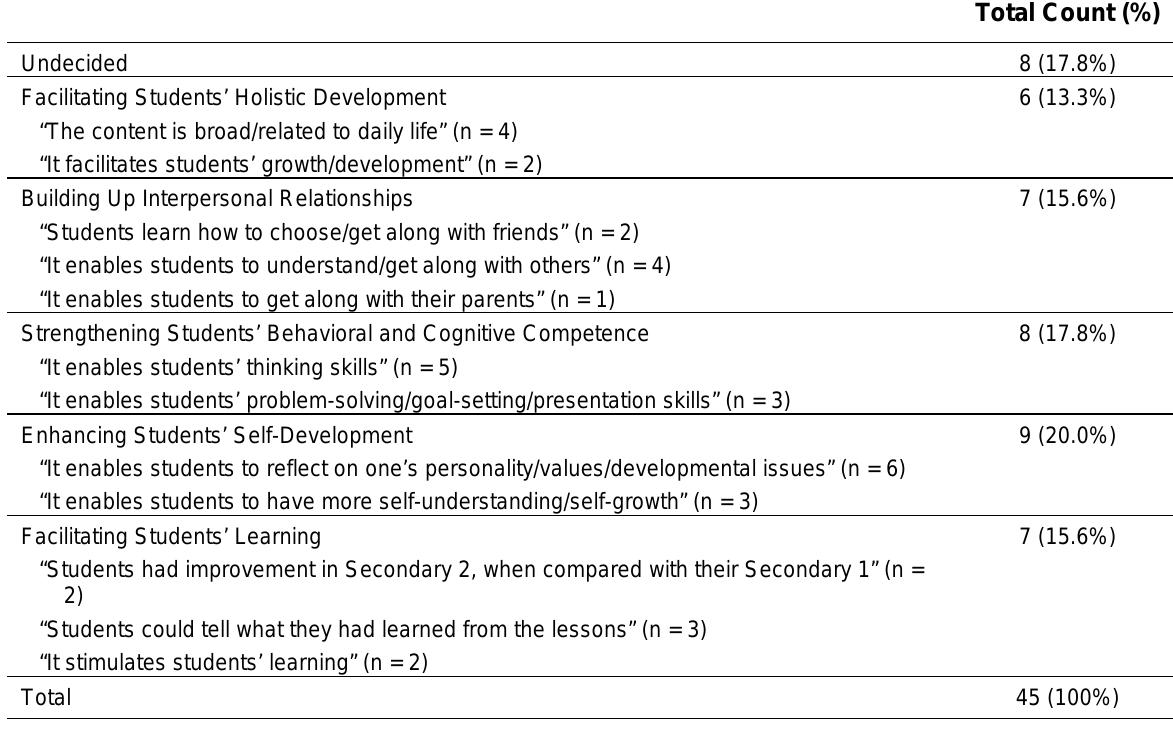
Workers’ Perceptions of the Benefits of the Secondary 2